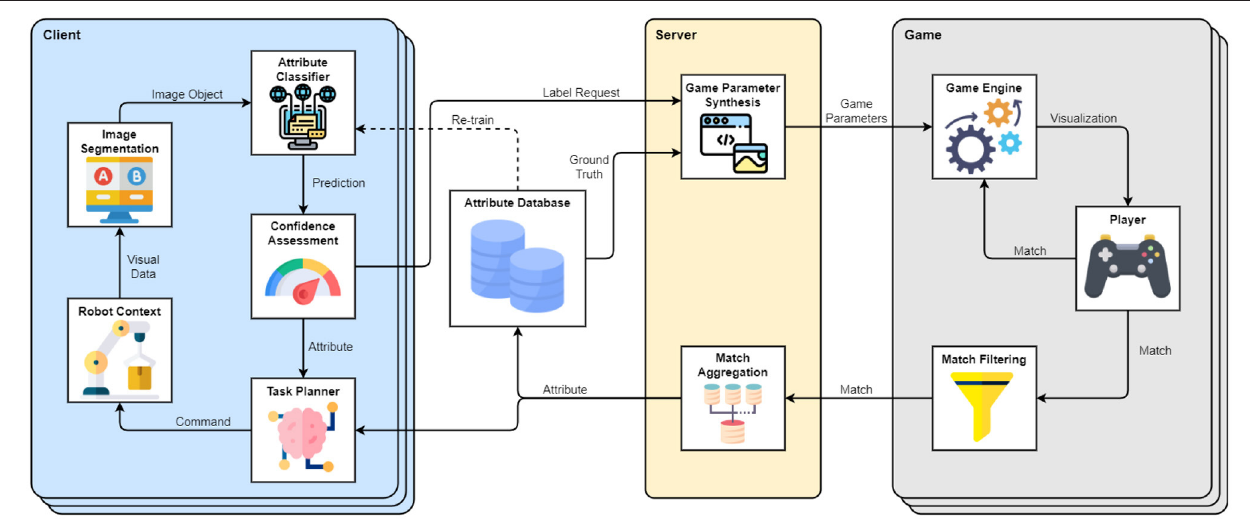
FIGURE 1 | Structure and flow of information within the proposed attribute matching framework. The example client manages a Robot Context that relies on an Attribute Classifier to characterize objects detected in the robot environment. Predictions of the Attribute Classifier are assessed based on their confidence, and the client can request assistance with labeling the low-confidence predictions. The Label Request passes to the server, which synthesizes Game Parameters by combining ground truth and received data. The Game Parameters are passed to the Game Engine, which is accessible to the users. The players create matches between the known and unknown images based on their attributes. The matches are filtered and returned to the server, which aggregates them to estimate the Attributes of the unknown images. The results are passed to the client, which can use them directly in the Task Planner. When a label reaches high enough confidence and number of matches, it becomes known / validated and is included in the database, which can be utilized to re-train the classifier of the client. The framework is flexible on the client side and can be adapted to arbitrary task specifications. Icons were sourced and modified from Flaticon